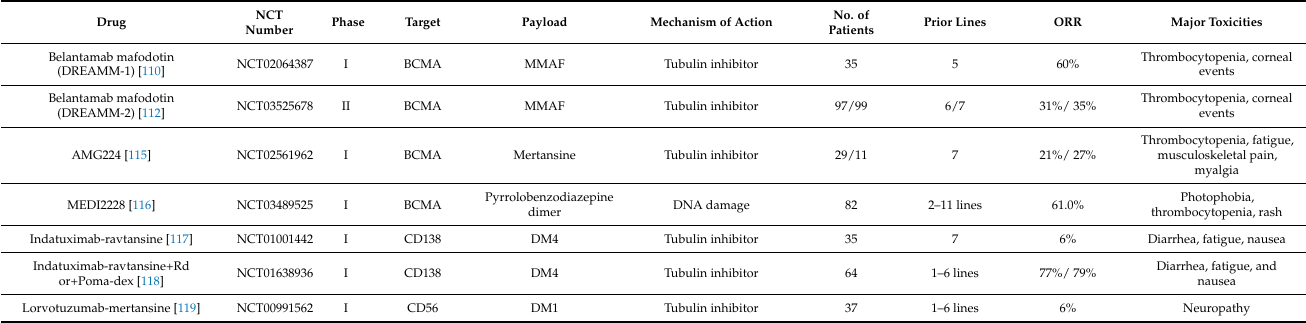
Table 9. Results of selected trials with ADCs.